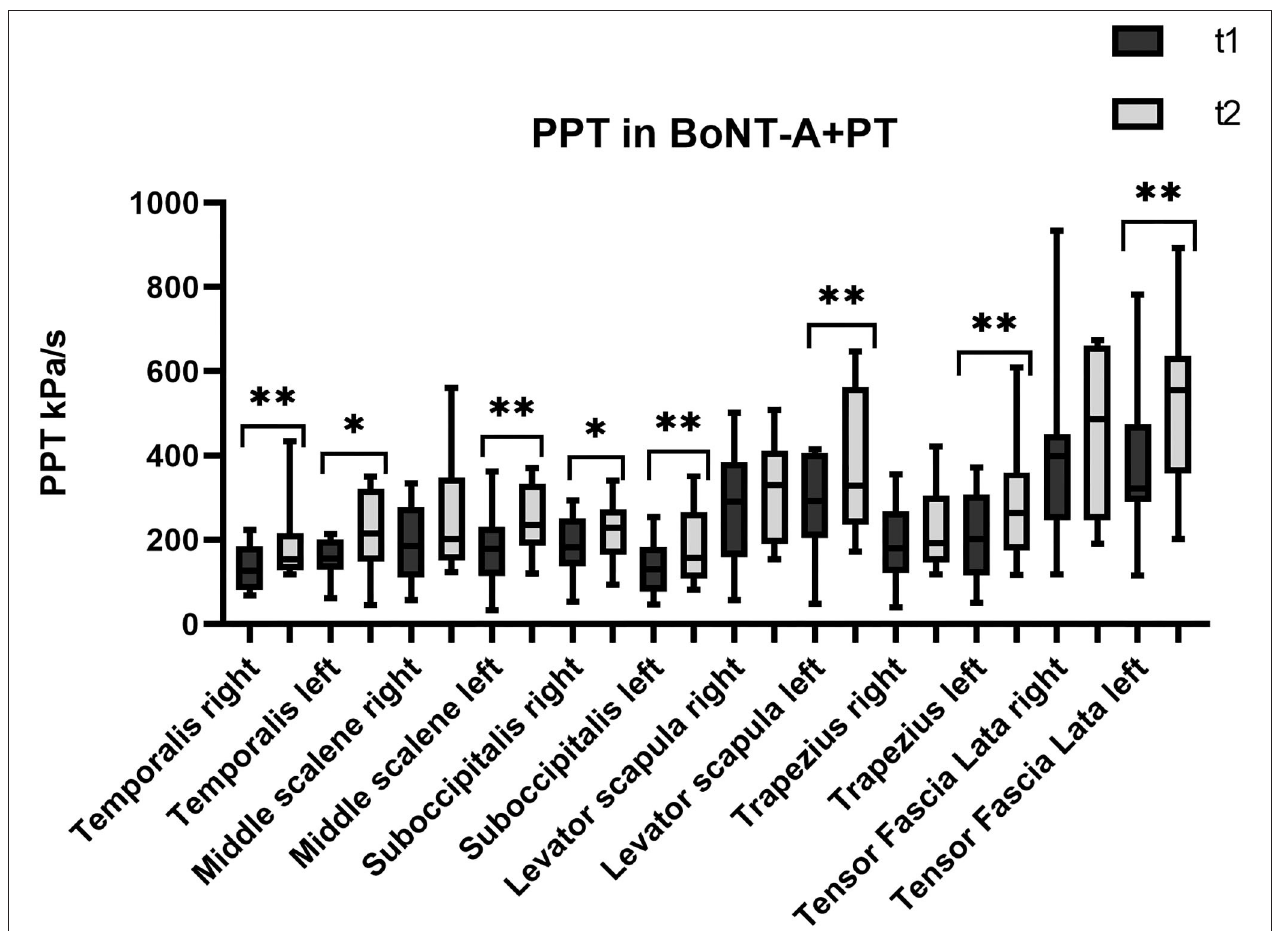
FIGURE 2 | Pressure pain threshold over the trigeminal and extra-trigeminal area before (T1) and after (T2) onabotulinumtoxin-A + physical therapy (BoNT-A + PT) treatment. * p value < 0.05, ** p value <